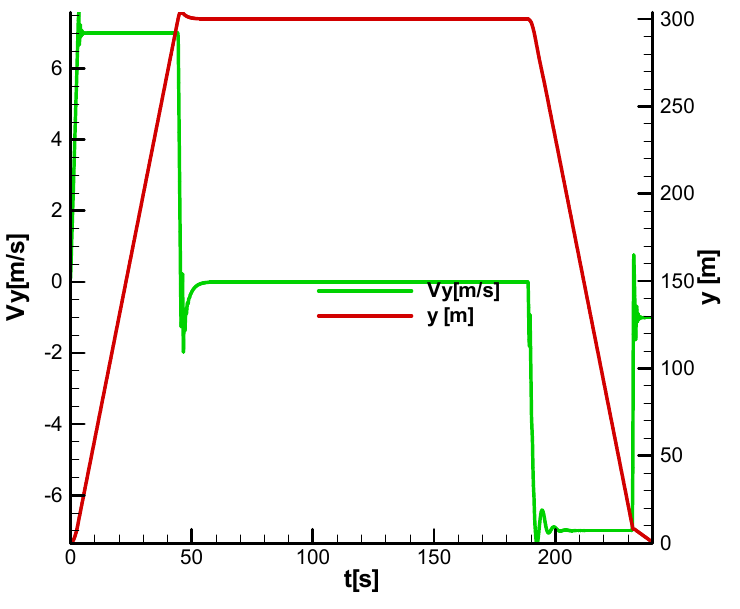
Figure 19. Vertical velocity and altitude.